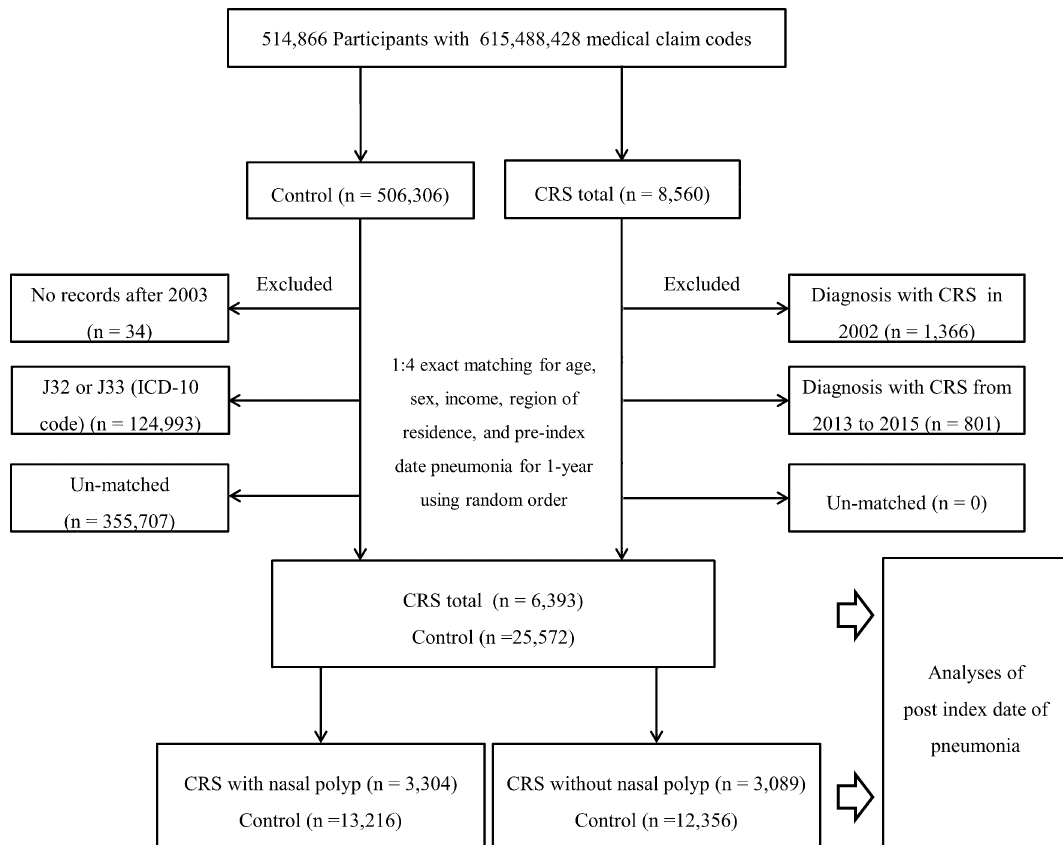
Figure 1. A schematic illustration of the participant selection process that was used in the present study. Of a total of 514,866 participants, 6,393 of the total CRS participants were matched with 25,572 control participants for age, sex, income, region of residence, and pneumonia for 1 year prior to the index date. Additionally, the final participants were further classified into two groups: CRS with nasal polyps (n = 3,304) with matched controls (n = 13,216) and CRS without nasal polyps (n = 3,089) with matched controls (n =